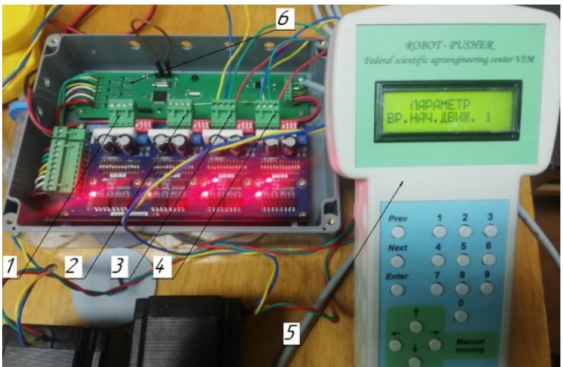
Figure 10. Time Elements of the control system of the pusher robot; 1, output to the left wheel drive; 2, output to the right wheel drive; 3, output to the pusher auger drive; 4, output to the dispenser drive; 5, control panel for changing the parameters of automatic operation; 6, input signal processing